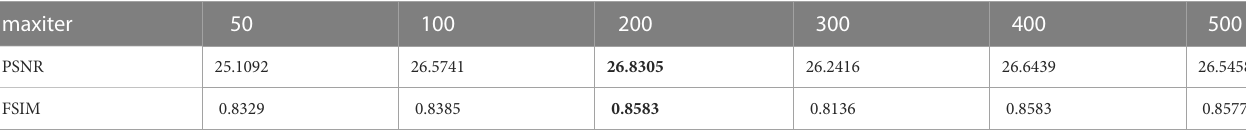
TABLE 3 Effect of experimental results by maximum iteration number